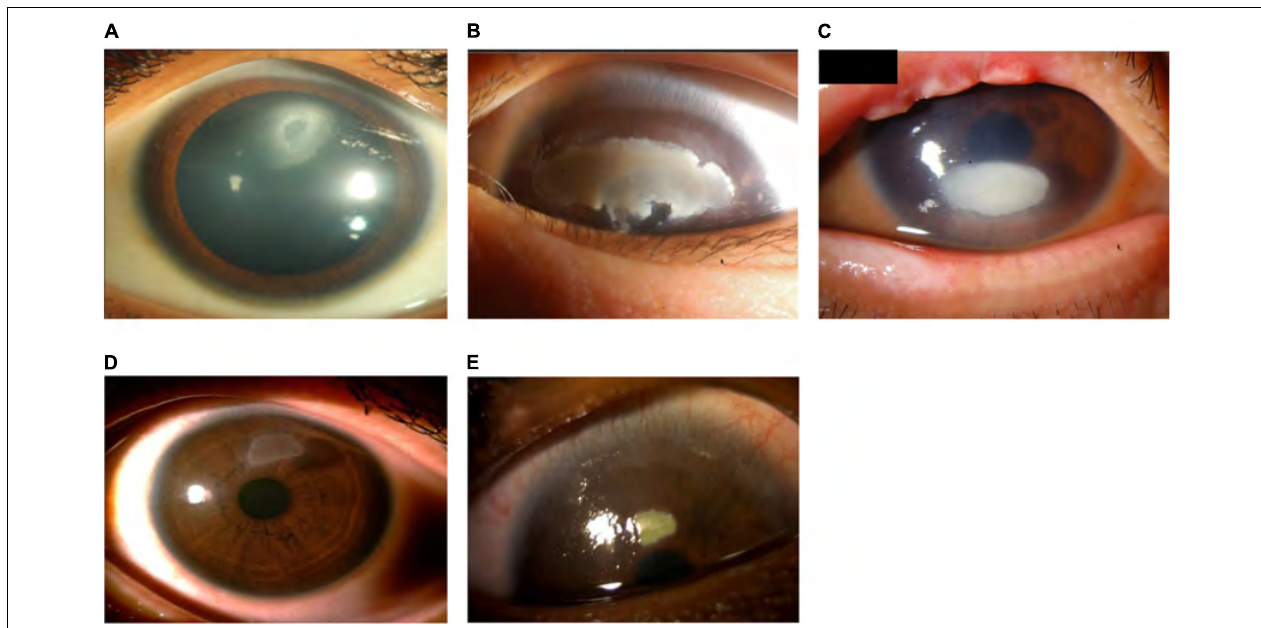
FIGURE 4 | Patients with shield ulcer formation. Shield ulcers usually form on the upper third of the cornea. Plaques can also form when inflammatory debris accumulates at the base of a shield ulcer. (A) Image courtesy of Ramesh Kekunnaya; (B,C) images courtesy of Wei-Li Chen; (D) image courtesy of Leo Seo Wei; (E) image courtesy of Dominique